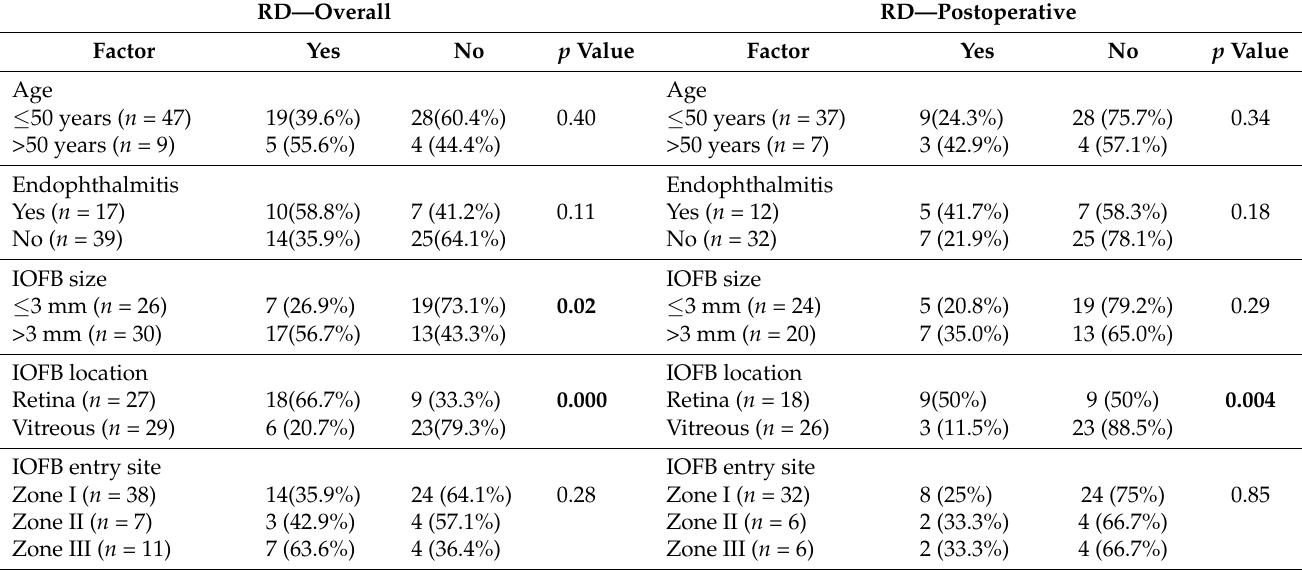
Table 4. Factors influencing RD